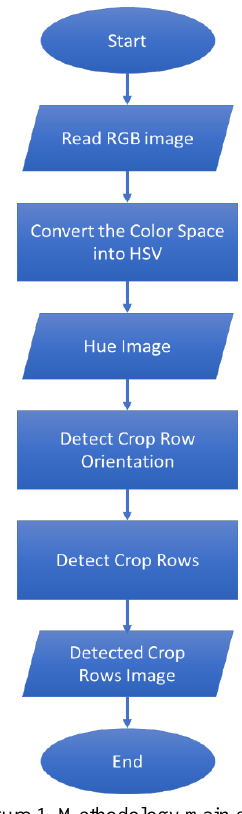
Figure 1. Methodology main